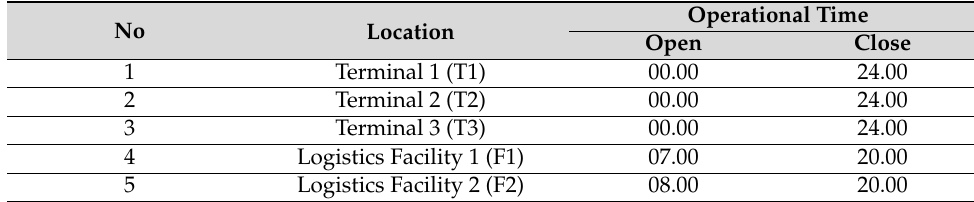
Table 2. Operational times of terminals and logistics facilities.